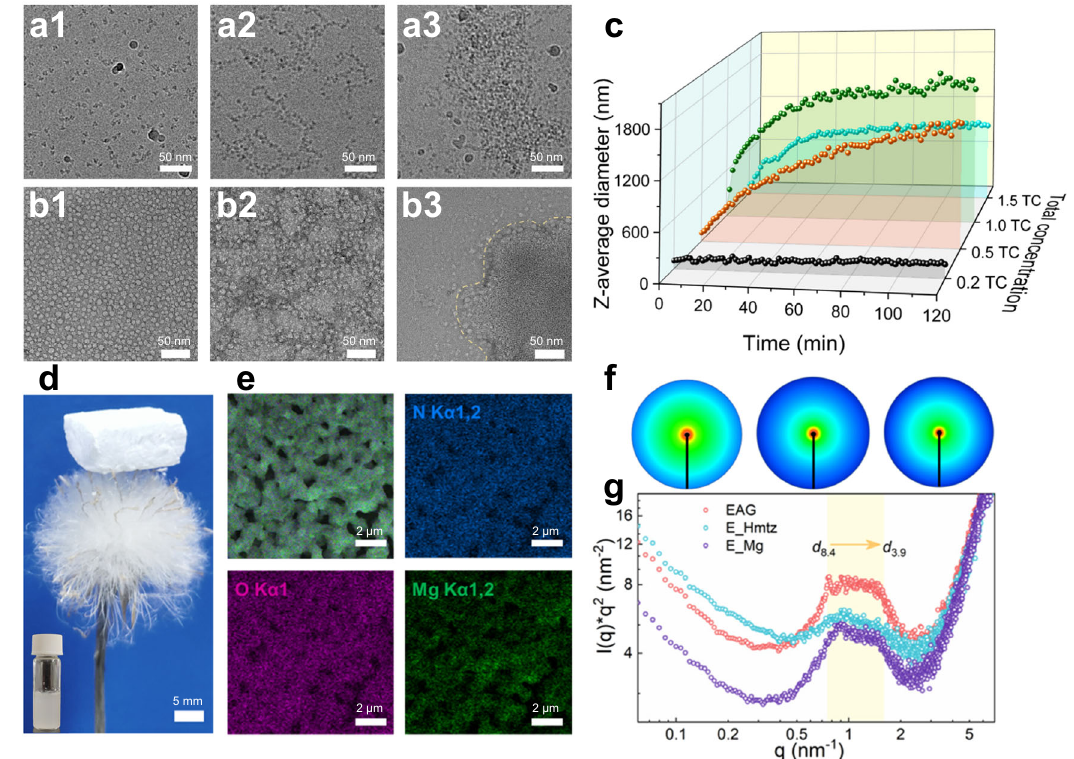
Fig.2|CharacterizationofEAG.a Cryo-TEMand b negativelystainedTEMimages of the free enzyme obtained (1) before pre-gelation, (2) after pre-gelation, and (3) after gelation. Both the pre-gelation and gelation processes were terminated at 2min. Black particles in ( a ) and white particles in ( b ) represent enzyme molecules. For ( a ) and ( b ), representative images from fi ve independent experiments are shown. In ( c ), In situ DLS assays obtained during the pre-gelation process at dif- ferentenzymeconcentrationsandatemperatureof25°C.Notation1.0TCrefersto